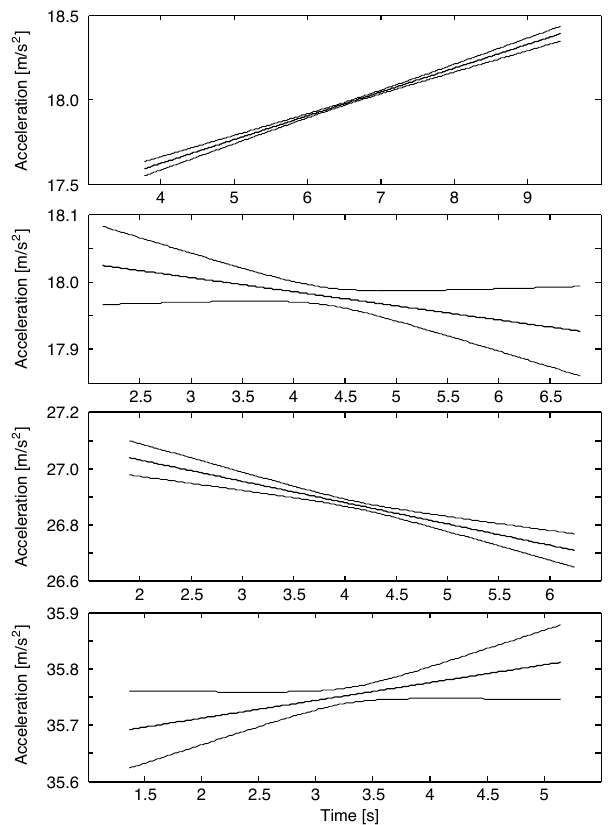
Fig. 6. Variation of the acceleration calculated from the Doppler frequencies shown in Fig. 3 (heavy lines). The thin lines indicate the 3 σ limits.